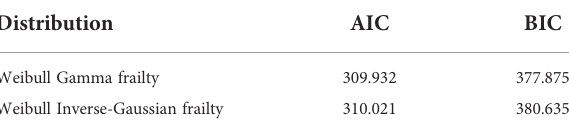
TABLE 7 Comparison of Weibull Gamma frailty and Weibull Inverse- Gaussian frailty model. Distribution